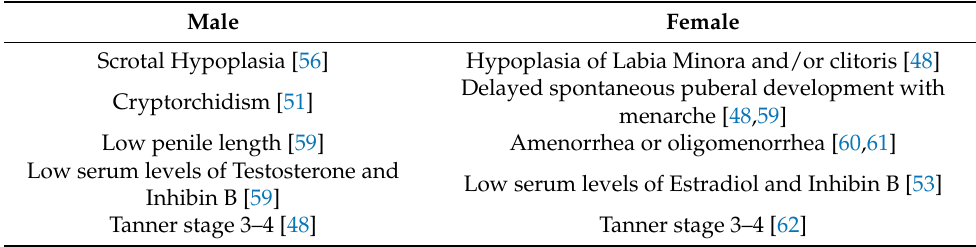
Table 2. Manifestations of